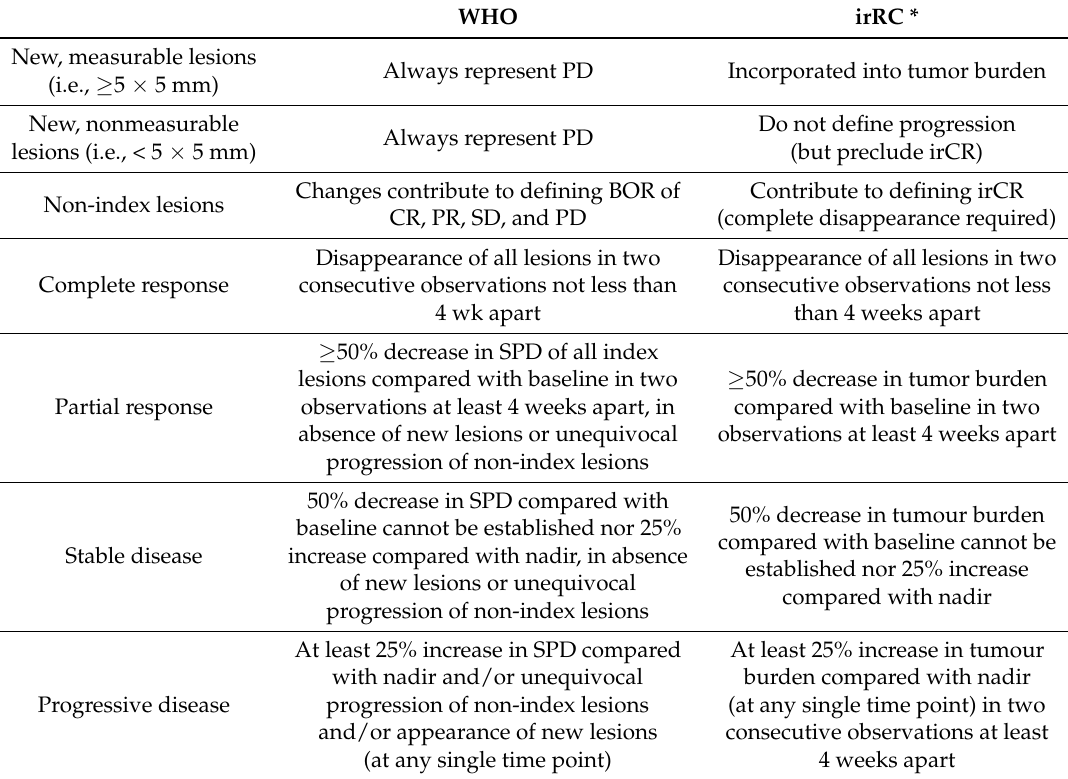
Table 2. Comparison between WHO criteria and the irRC